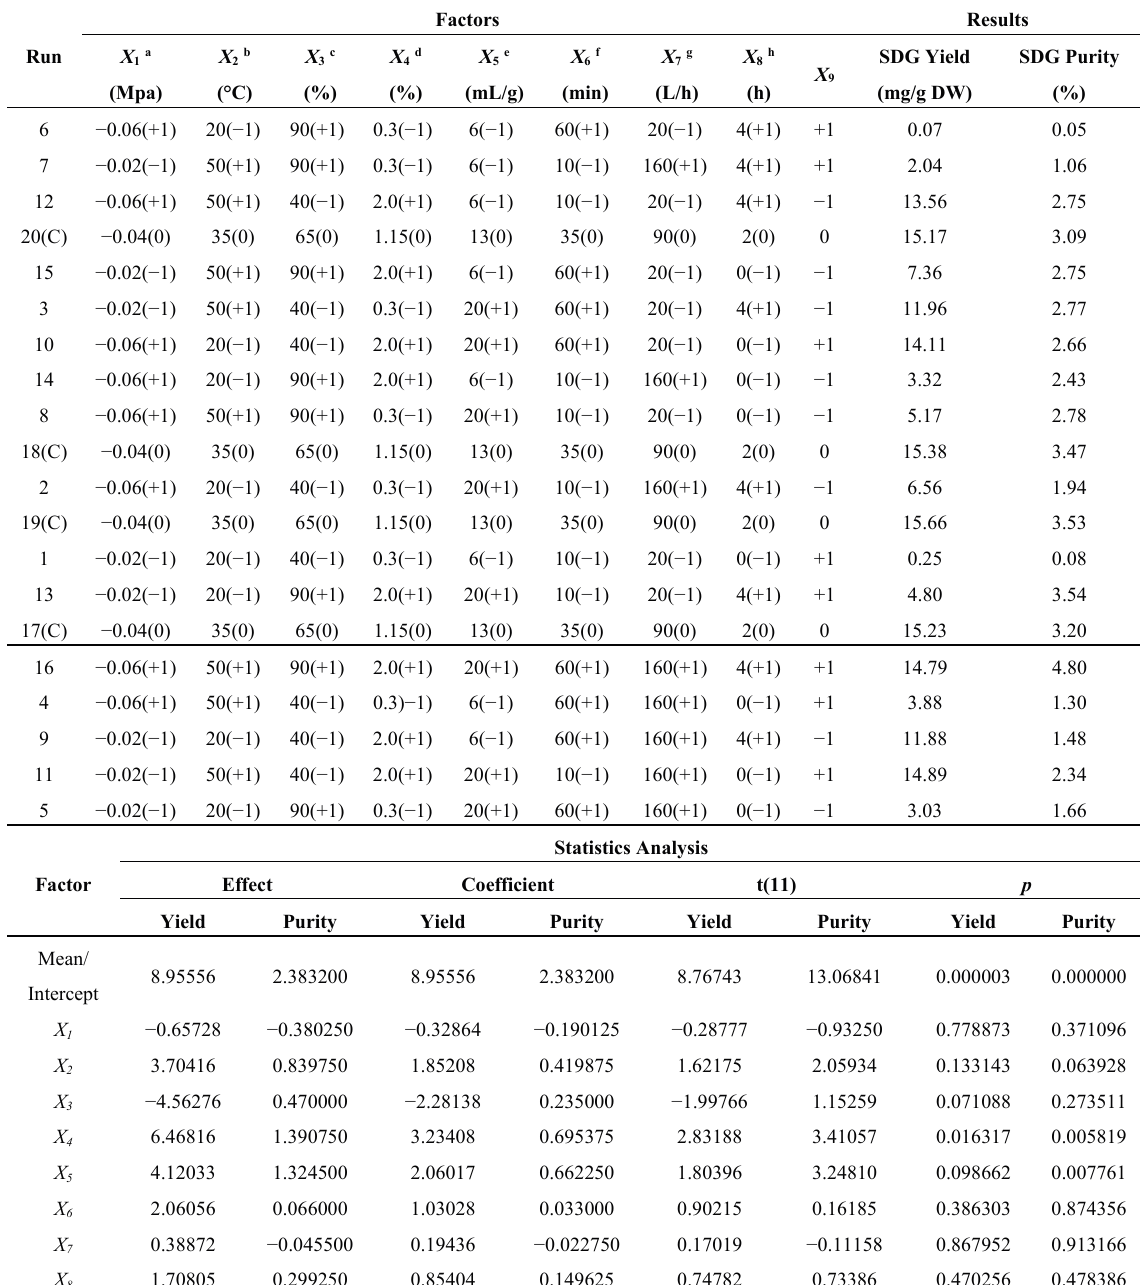
Table 1. Levels of the variables tested in the 2 (9 − 5) experimental design and statistics analysis of secoisolariciresinol diglucoside (SDG) yield and